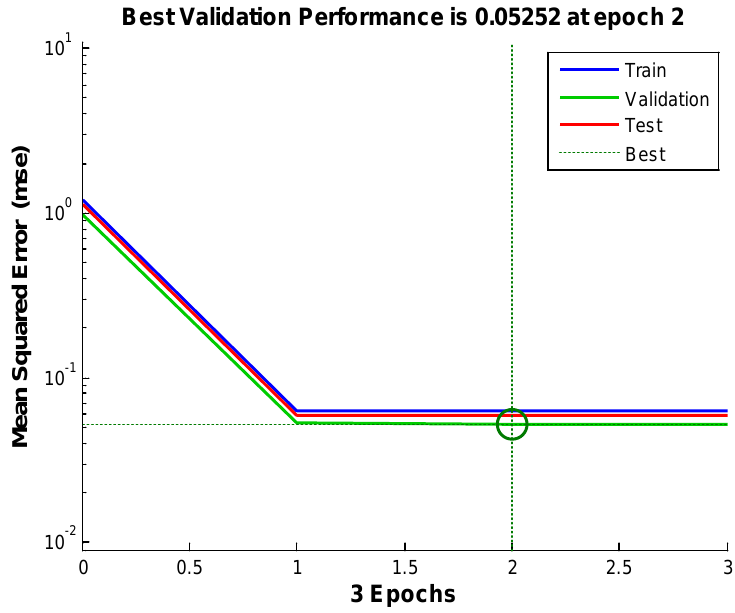
Figure 10. Neural network-based data assimilation result for station 3.